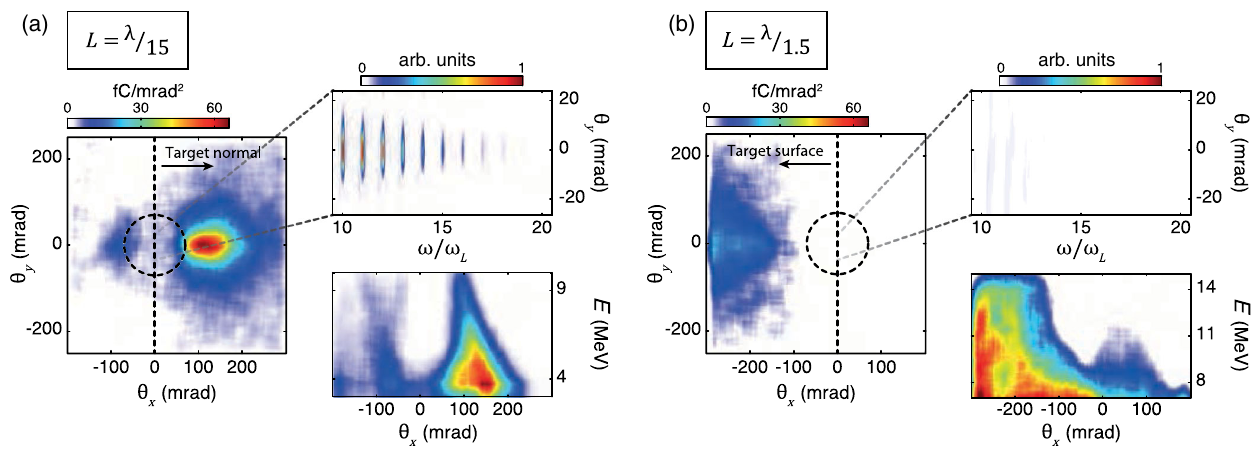
FIG. 6. 3D PIC simulations of the laser-plasma interaction for two different density gradient scale lengths, L . The physical conditions of these simulations are matched to the estimated experimental conditions of the shots shown in the lower part of Fig. 2: panel (a) corresponds to a density gradient L 1 ¼ λ = 15 and panel (b) to L 2 ¼ λ = 1 . 5 , while all other physical parameters remain the same. From these simulations, we extract the same observables as those measured in the experiment: the angular profile of the high-energy electron beam expelled in vacuum (left-hand image in each panel), the ð θ x ; E Þ distribution of these electrons (bottom right-hand image in each panel), and the angularly resolved harmonic spectrum (top right-hand image in each panel). The key features are the same as those observed on the experimental results (compare with the lower panels of Fig.